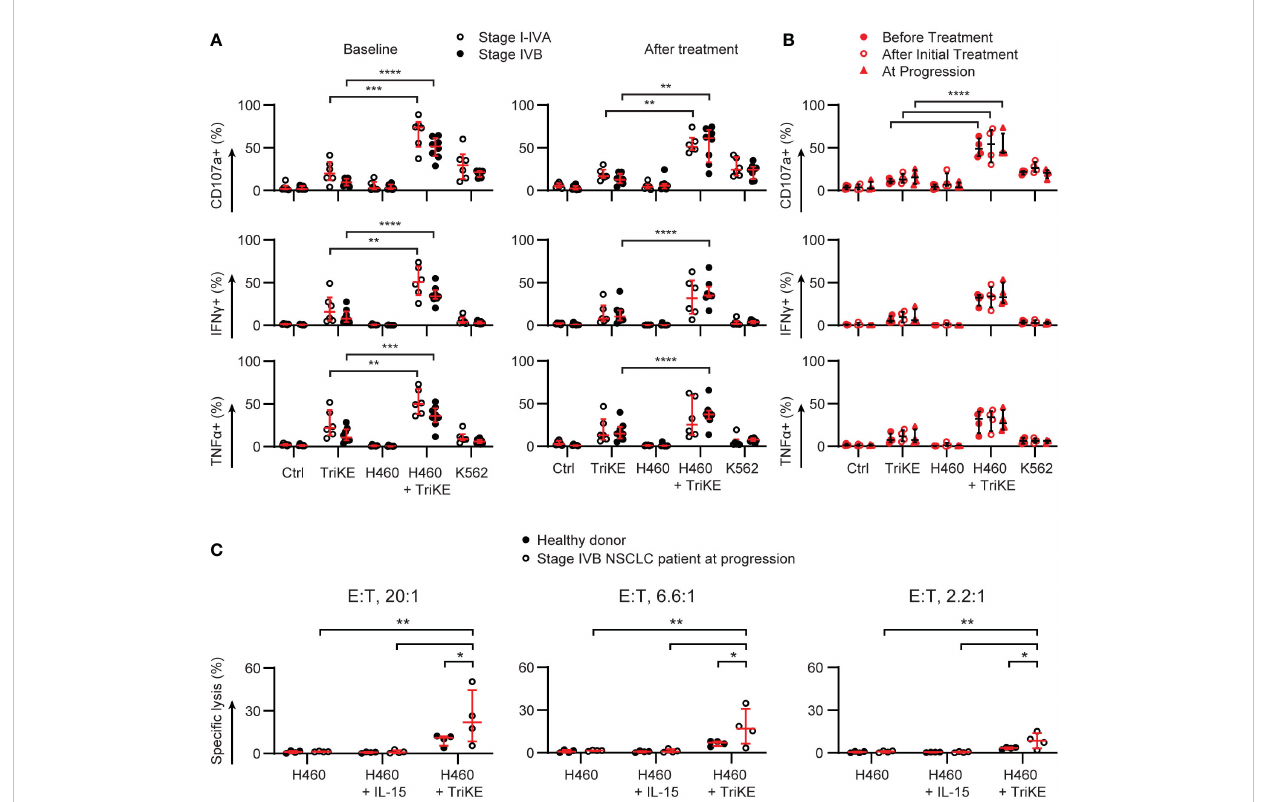
FIGURE 7 TriKE triggers responses against lung cancer cells by lung cancer patient NK cells at all stages of disease and treatment. PBMC from donors with non-resectable NSCLC were cultured for 5 hours alone (Ctrl), with a lung cancer cell line (NCI-H460) or a chronic myeloid leukemia cell line (K562) in the presence or absence of cam1615SS1 (TriKE). The amount of degranulation (CD107a+) and cytokine secretion (IFN g and TNF a ) by NK cells (CD56+ CD3-) was assessed by fl ow cytometry. (A) The data are organized according to the stage of treatment (before treatment – left; after treatment - right) or the disease stage (symbols, I-IVA n=6, IVB n=8). (B) The NK cell responses of four stage IVB NSCLC patients for whom progression samples were available are plotted according to the timepoint of treatment. (C) Lysis of NCI-H460 by PBMC was assessed in a 5 h chromium release assay with or without IL-15 or TriKE (both 30nM). Three effector to target (E:T) ratios were probed for healthy donors or the most at risk NSCLC patients (n=4). In all graphs, bars show the median and interquartile range. Analyzed by two-way repeated measures ANOVA with multiple comparison tests (highlighting just the TriKE and TriKE + H460 comparisons in A&B) * p<0.05, **p<0.01, *** p<0.001, ****